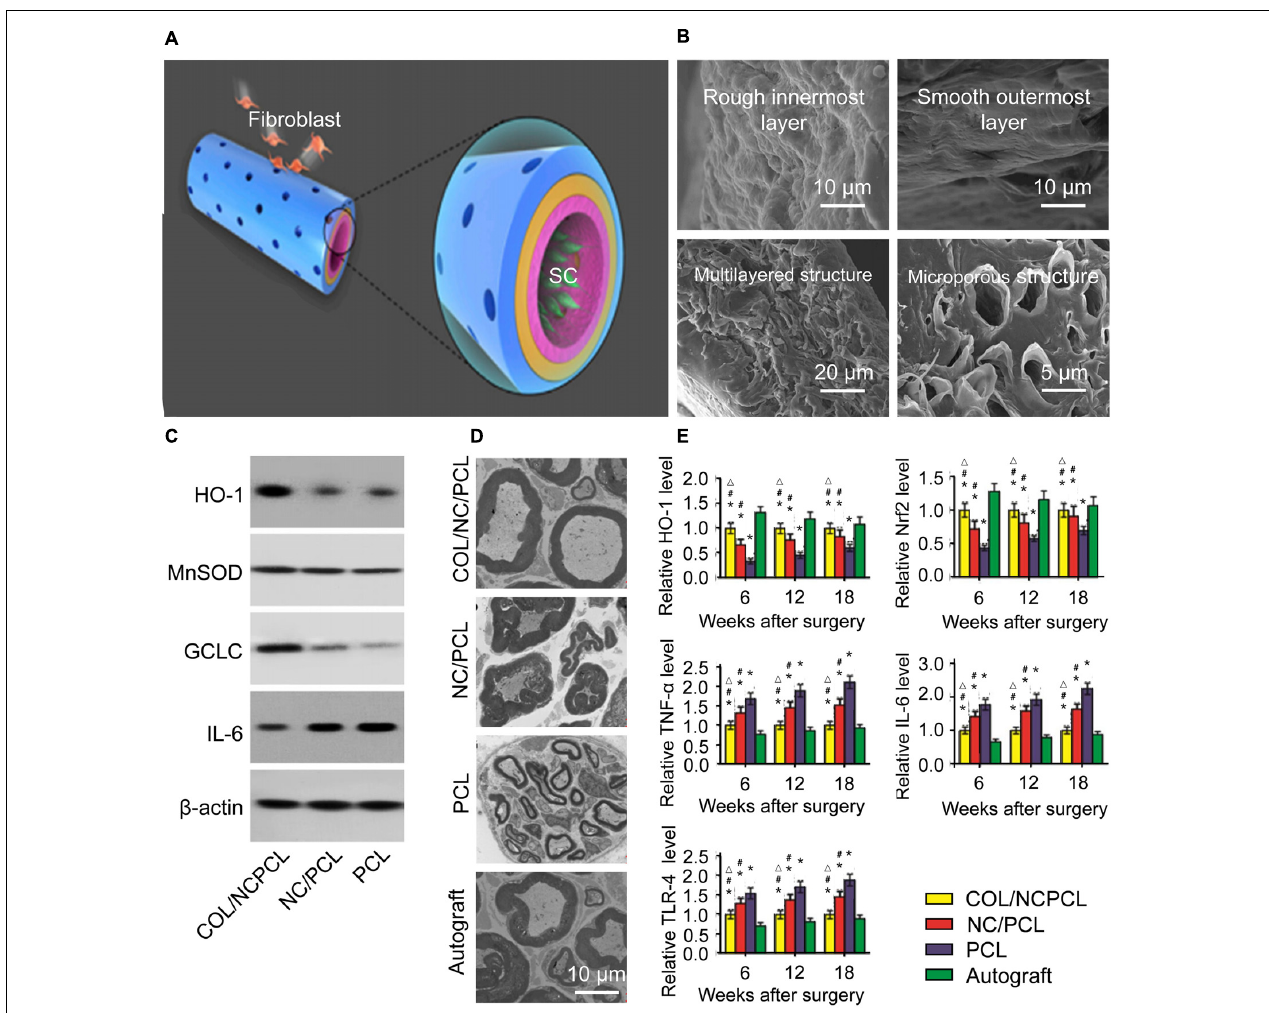
FIGURE 4 | Schematic diagram of the 3D fabrication of the Col/NC/PCL NGCs, transmission electron micrograph of a sciatic nerve after surgery and the antioxidant properties of Col/NC/PCL NGCs (Qian et al., 2019). (A) The Col/NC/PCL NGC was printed in three layers from the outside to the inside, the Col layer, PCL layer, and NC/PCL layer. The inner layer was suitable for SC adhesion, and the outer layer could prevent fibroblasts from entering the conduit. (B) SEM of the Col/NC/PCL NGCs; (C) Western blot results of in vitro antioxidant and anti-inflammatory indicators; (D) Transmission electron micrograph of the sciatic nerve 18 weeks